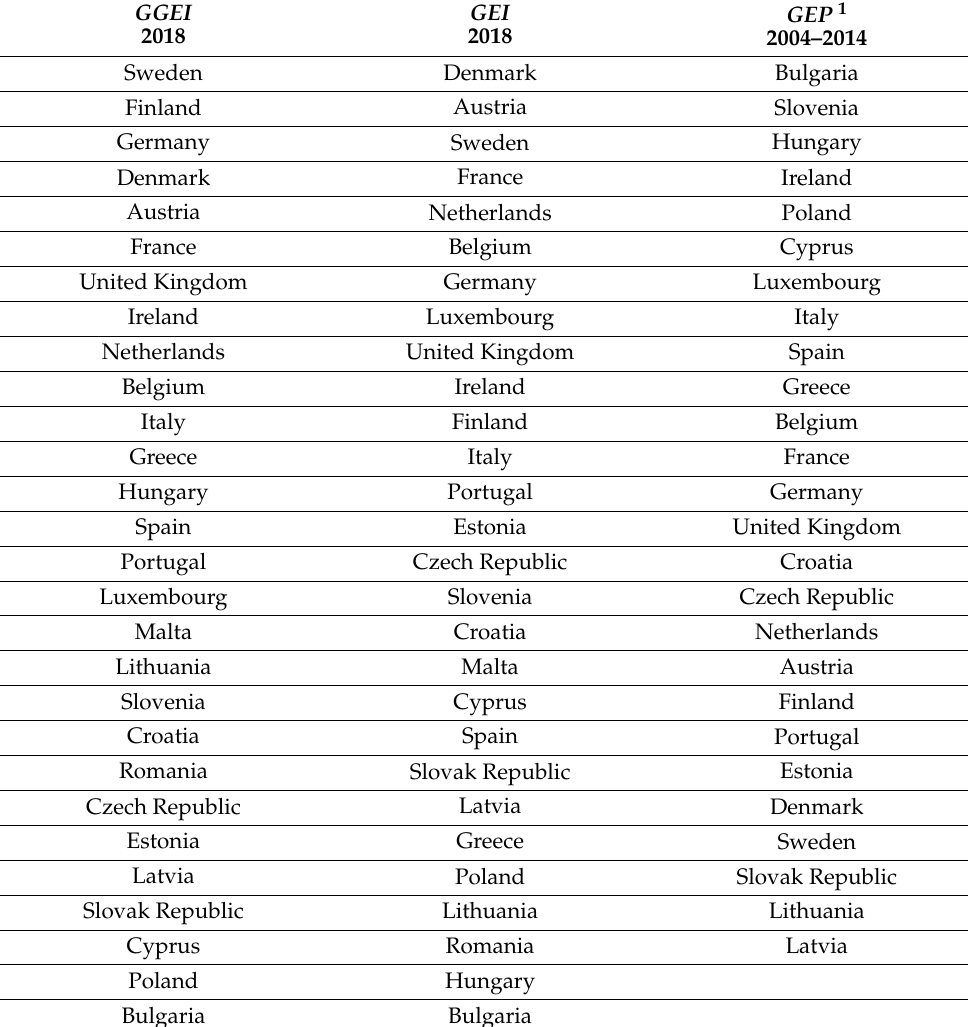
Table 4. Comparison of the rankings of EU countries based on Global Green Economy Index (Dual Citizen Inc.), Green Economy Index (Kasztelan) and Green Economy Progress